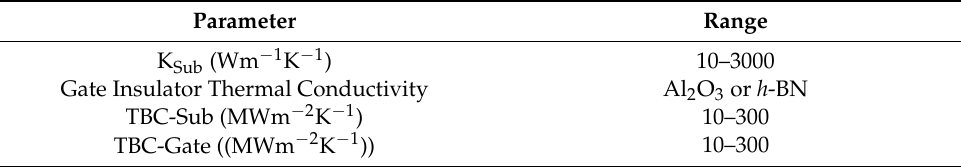
Table 2. Feasible range of parameters in the 3-D thermal simulation.